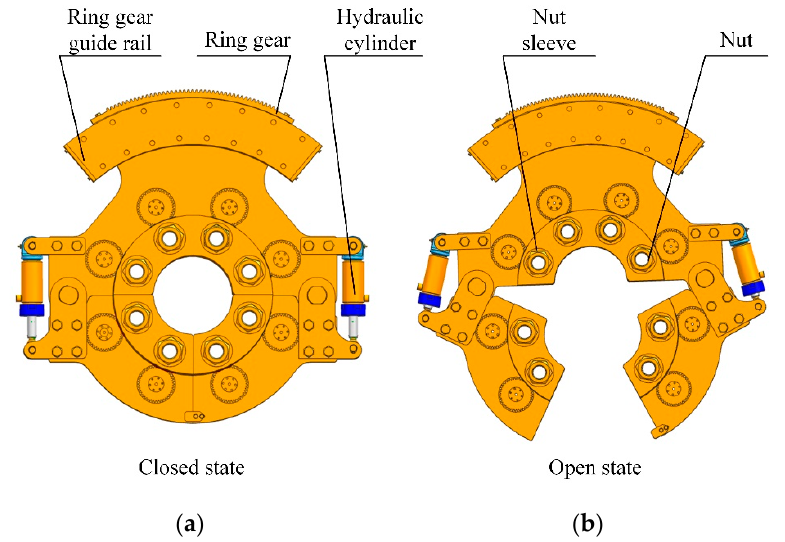
Figure 3. The structure of the nut magazine in the closed state ( a ) and open state ( b ). The torsion angle α is the angle of the Z i-1 axis and Z i axis about the X i axis; the joint i angle θ i is the angle of the X i-1 axis and X i axis about the Z i-1 axis, the length a i is the distance between the Z i-1 axis and Z i axis along the X i axis, and the offset d i is the distance from the origin O i-1 of the i − 1 coordinate system to the X i axis along the Z i-1 axis. According to the D–H method, the general transformation formula is as follows: